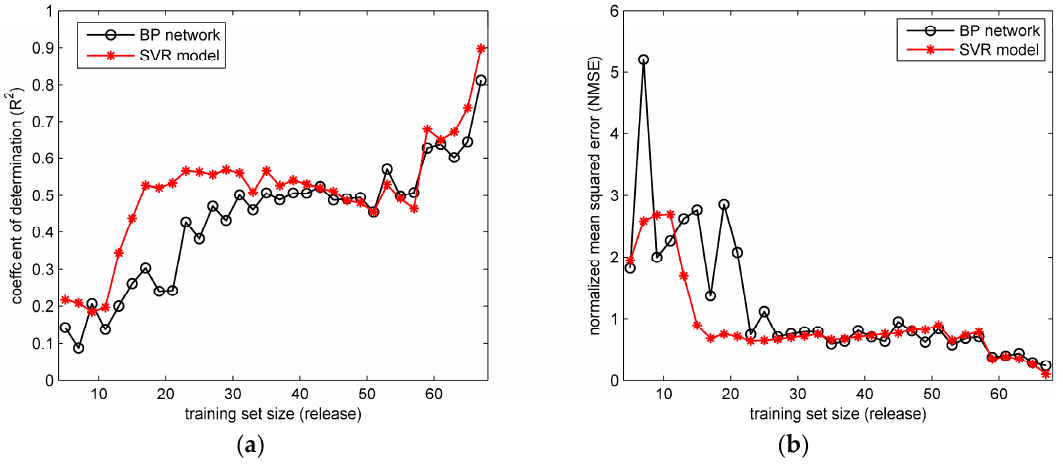
Figure 10. The performances of BP network and SVR model with training sets of different scales in the Prairie Grass case: ( a ) the coefficient of determination ( R 2 ); ( b ) the normalized mean squared error (NMSE).